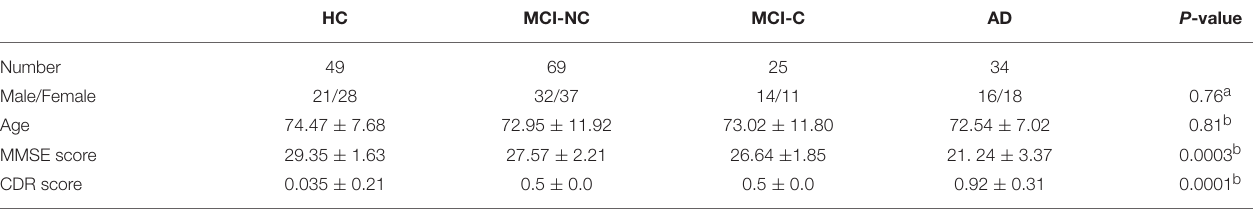
TABLE 1 | Demographic and clinical